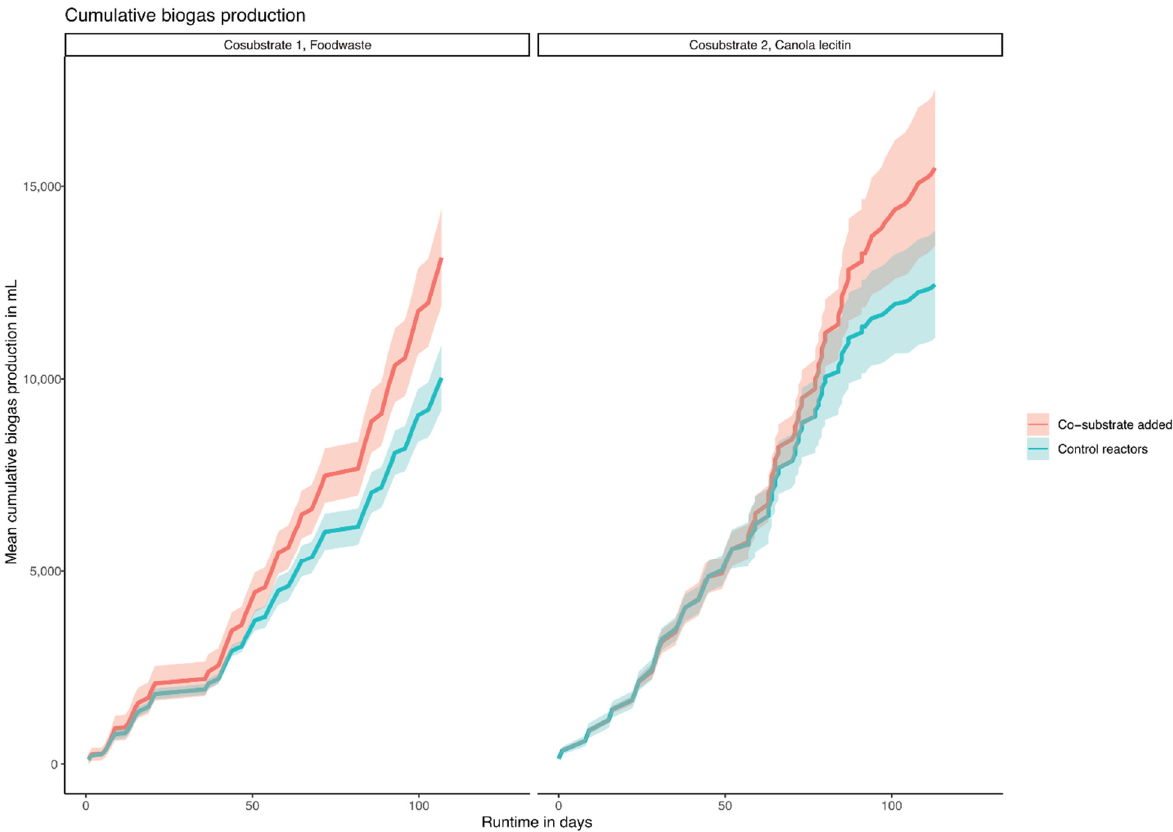
Figure 1. Cumulative biogas production of the two experiments per reactor, in mL, with standard deviation, over time. Food waste on the left, canola lecithin on the right.